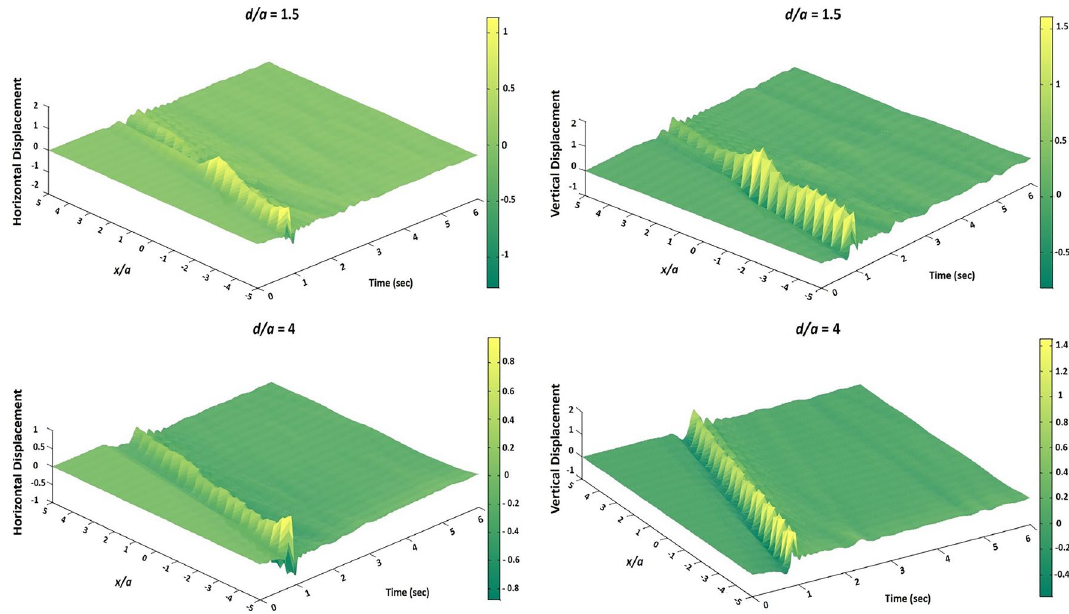
Fig. 8 Synthetic seismograms of normalized horizontal and vertical displacement of free surface induced by an underground cavity with depth ratios of 1.5 and